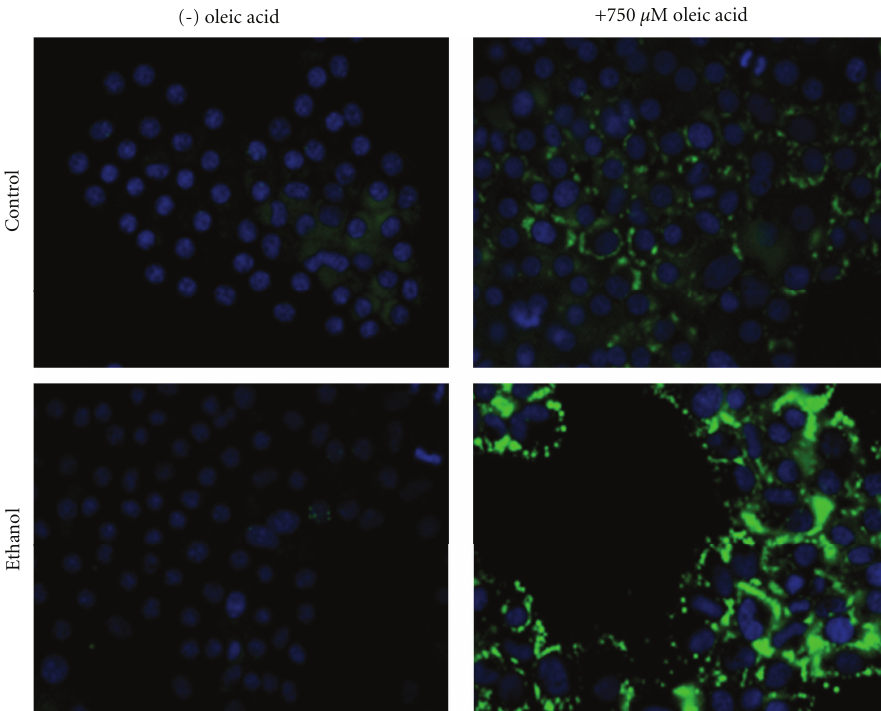
Figure 3: Lipid droplet accumulation in ethanol and oleic acid-treated cultures. WIF-B cells were treated without (control) or with 25mM ethanol in the presence of 750 uM oleic acid followed by immunohistochemical analysis of the presence of lipid droplets by BODIPY staining.